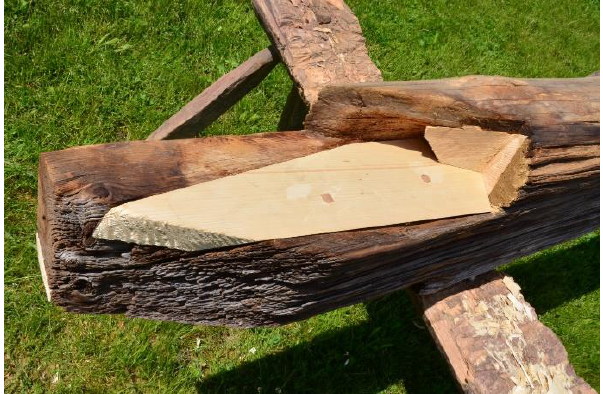
Figure 19. Dovetail joint of the damaged timber beam (H2) after the repair.